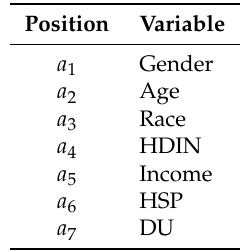
Table 6. Feature vector used in the proposed